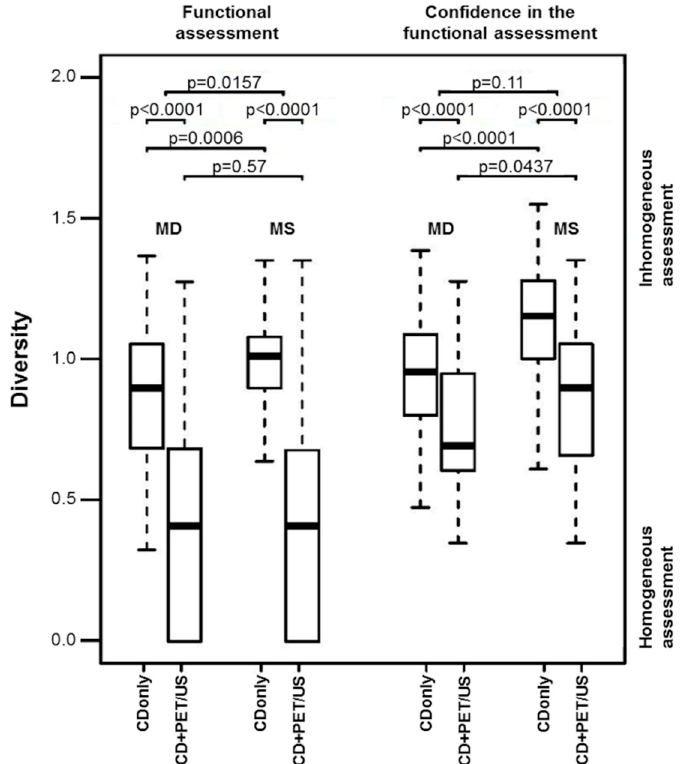
Figure 3. Diversity calculations of the observers’ functional assessment and the observers’ confidence in functional assessment of thyroid nodules (TN) for conventional diagnostics (CDonly) and CD + I-124-PET / US fusion imaging (CD + PET / US) illustrated by box plots. The horizontal lines within the boxes represent the median, the amplitude of each box the interquartile range, and the whiskers represent the minima and maxima. Higher diversity values represent more consistent assessments. The graphic illustrates a contrasting juxtaposition of the results of the nuclear medicine physicians (medical doctors, MD) and the medical students (MS).